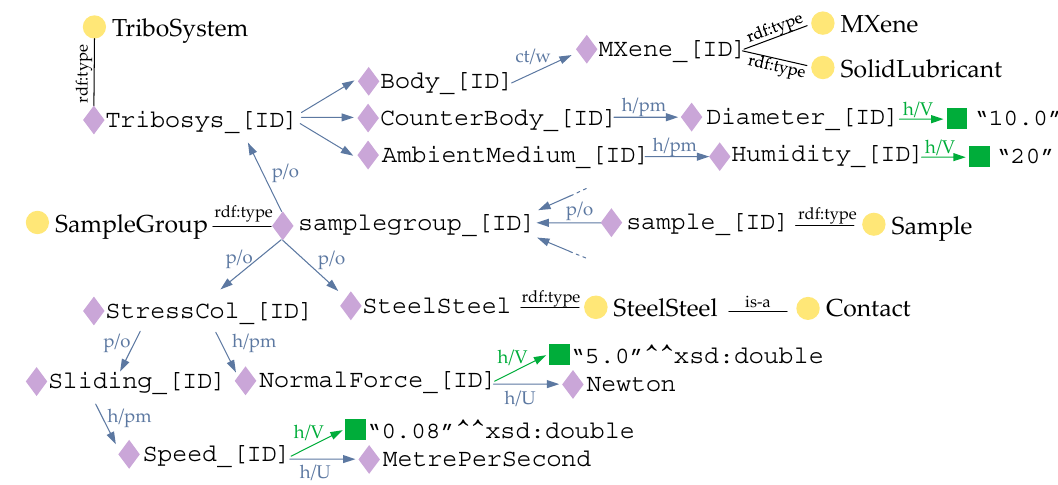
Figure 9. Excerpt of the formal experimental design description of a sample for testing MXene nanosheets as solid lubricants.